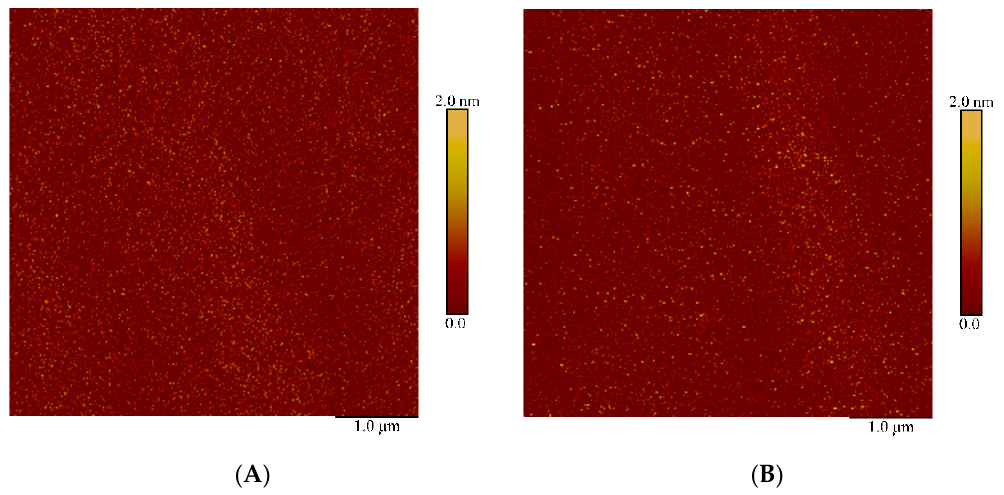
Figure 2. Typical atomic force microscopy (AFM) images obtained after incubation of DSP-activated ( A ) and SuccBB-activated ( B ) APTES-modified mica in water (Control 1).